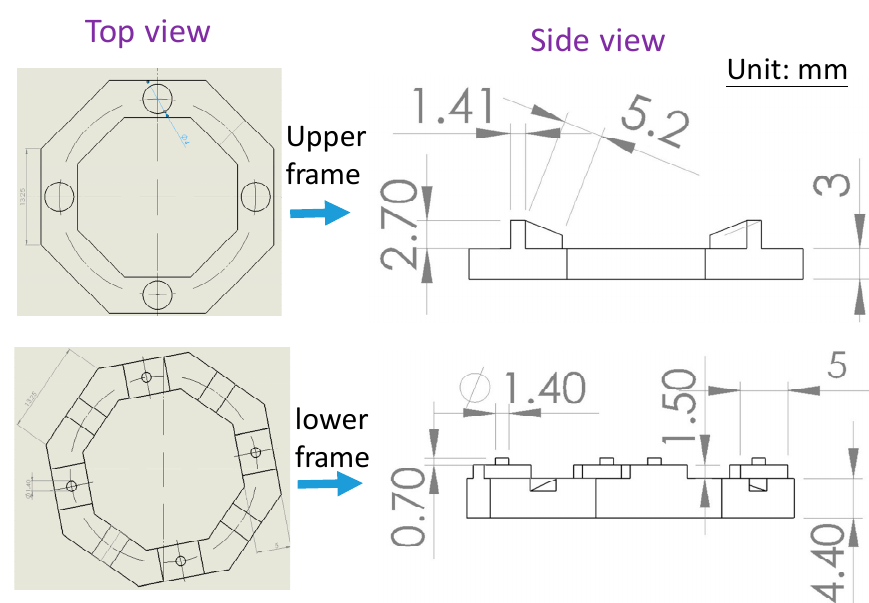
Figure 4. Design of the upper and lower frames by Solidworks.